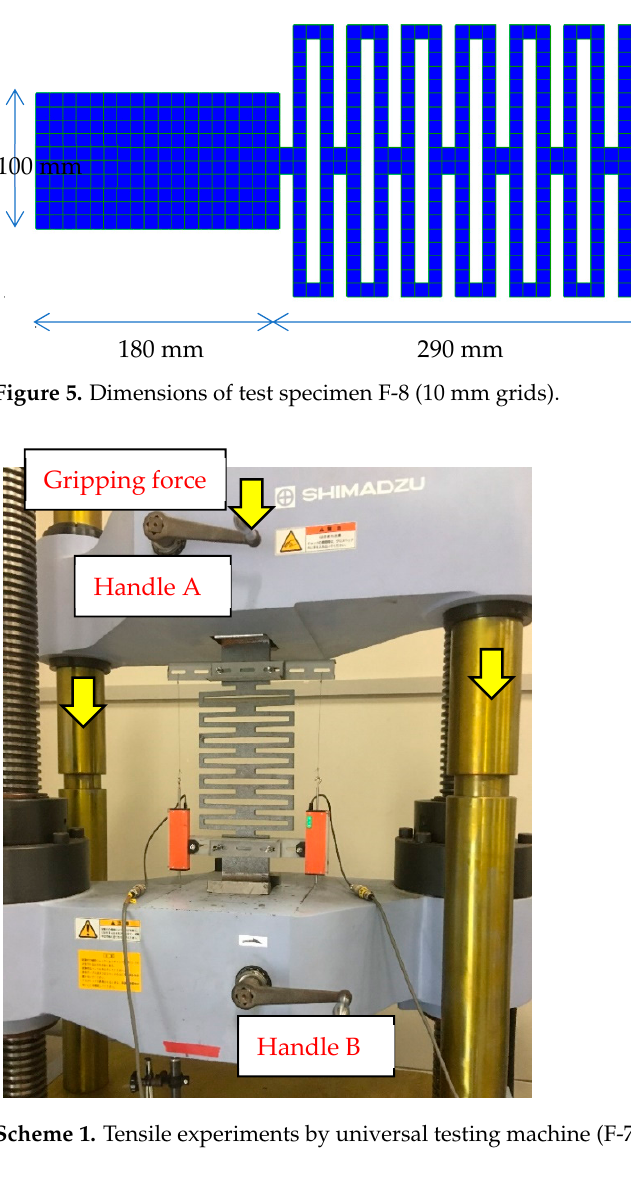
Figure 8. Von Mises stress distribution by FEM analysis with 2.5 mm grid elements (F-7). Figure 9. Von Mises stress distribution by FEM analysis with 2.5 mm grid elements (F-8). 6. Relationship between Yielding Deformation and Yielding Load of LDEPs Since the tensile yielding load is overestimated by the 10 mm rough grid elements according to experimental tests, a reanalysis with the 2.5 mm fine grid elements is re- quired after rough optimization. Table 3 shows the reanalysis results with the 2.5 mm grid elements for the solutions in Table 1. Here, yield strength of materials is 325 (MPa). Figure